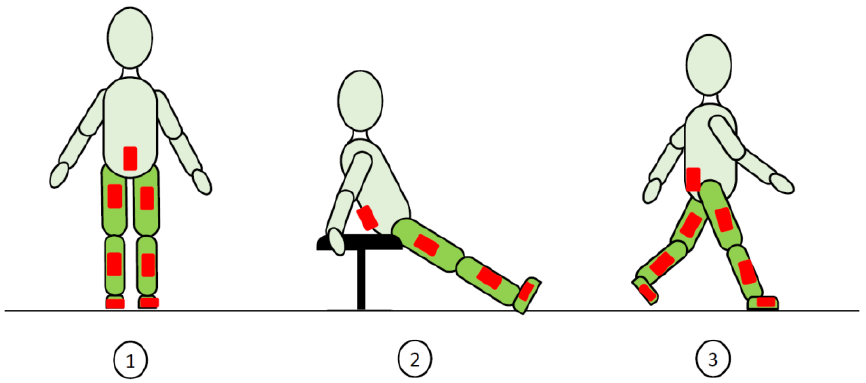
Figure 2. Tasks included in the protocol. ( 1 ) upright standing, ( 2 ) sitting with legs extended and ( 3 ) walking. IMUs are symbolized by the red boxes.